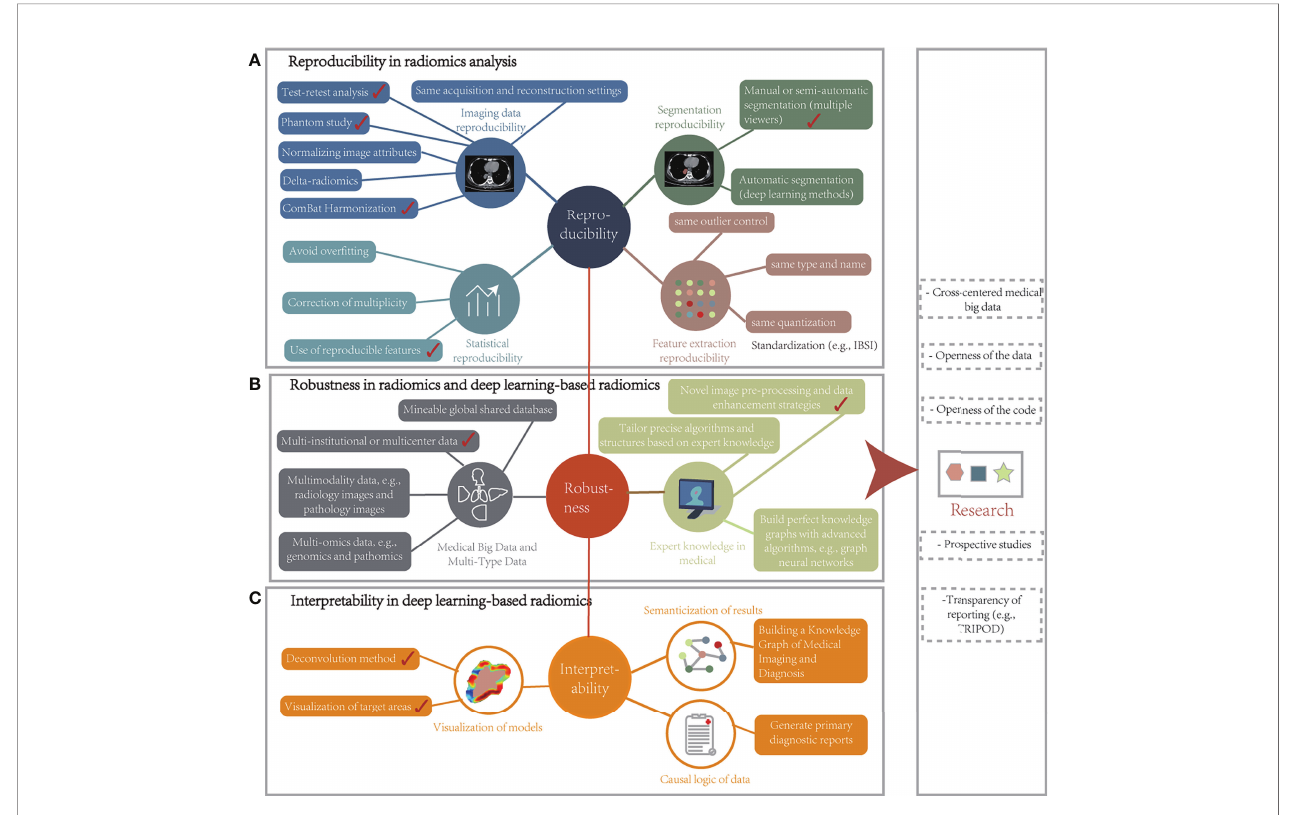
FIGURE 4 | Robust radiomic analysis framework. (A) Reproducibility in radiomics analysis can be obtained in terms of imaging data reproducibility, segmentation reproducibility, feature extraction reproducibility, statistical analysis reproducibility, and research reproducibility. (B) The robustness of radiomics and deep learning- based radiomics models could be improved in medical big data, multiple types of data, and medical expert knowledge. (C) Interpretability in deep learning-based radiomics can be enhanced concerning the visualization of models, semanticization of results, and causal logic of data. IBSI, Image Biomarker Standardization